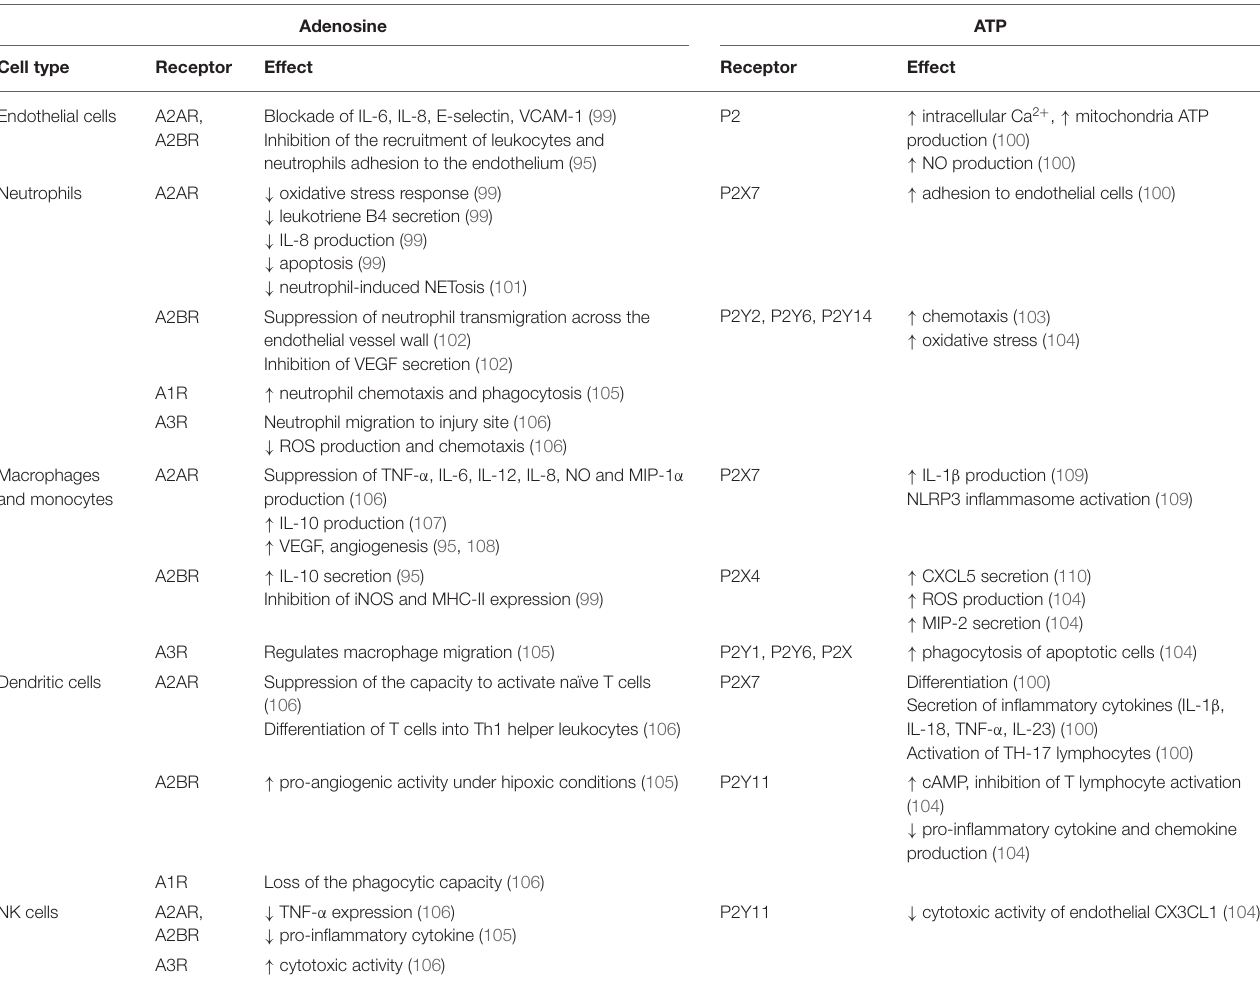
TABLE 1 | Effects of adenosine and ATP through their specific purinergic receptors in inflammation. Adenosine